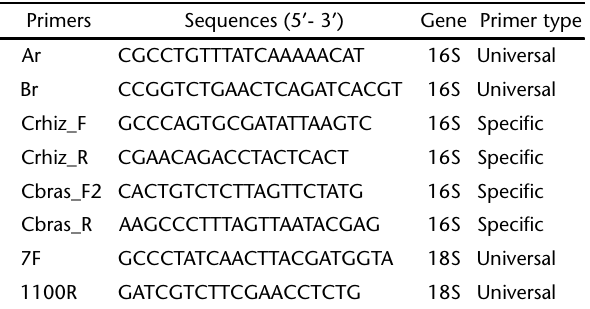
Table I. Primers used in PCR